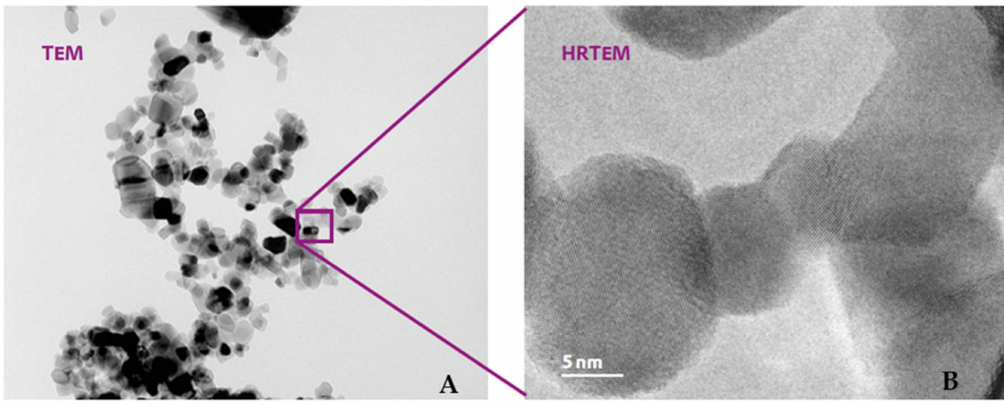
Figure 3. TEM images of nanometric TiO 2 depicting the primary crystals ( B ) obtained by mean HRTEM and their aggregates and agglomerates ( A